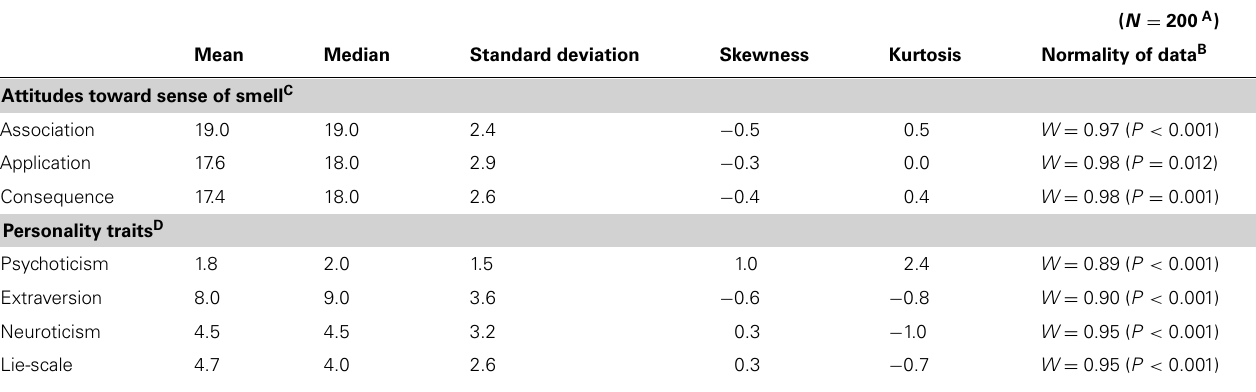
Table 2 | Descriptive analysis results for ratings of personality traits and attitudes toward sense of smell.